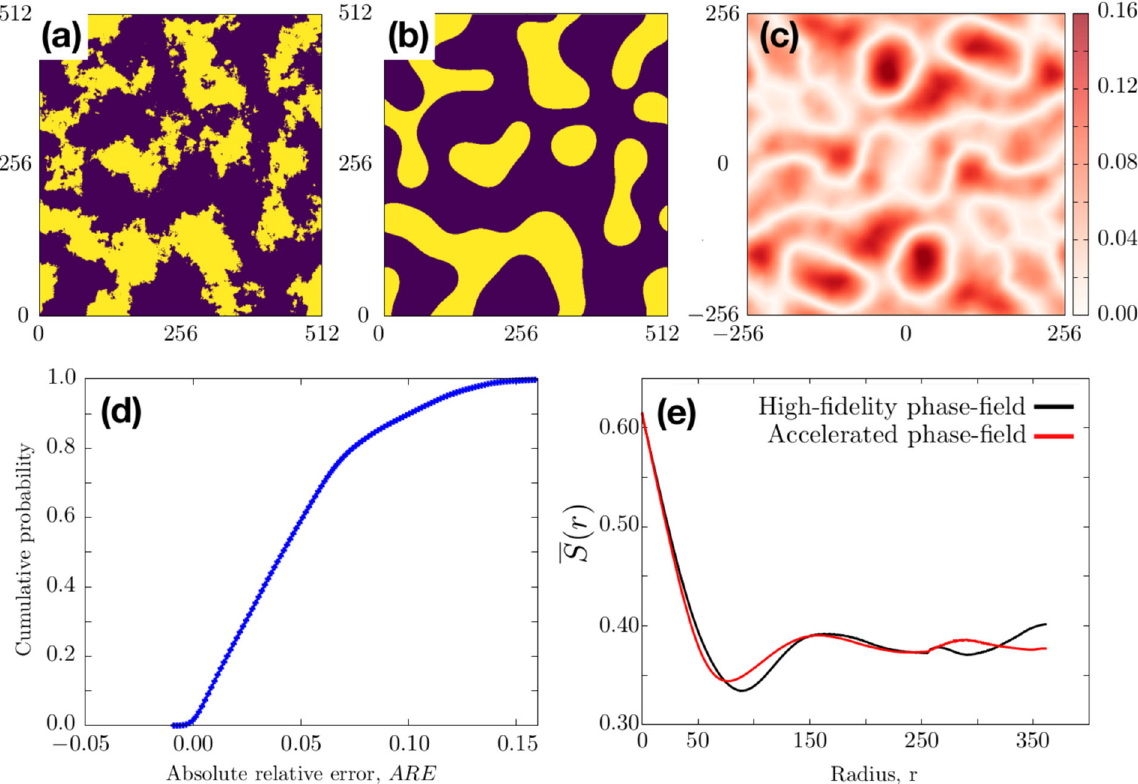
Fig. 5 Accelerated phase- fi eld predictions. a Reconstructed microstructure from the LSTM-trained surrogate model using a phase-recovery algorithm. b Phase- fi eld predictions using LSTM-trained surrogate model as an input. c Point-wise error between predicted and true microstructure evolution. d Cumulative probability distribution of the absolute relative error on characteristic microstructural feature size. e Comparison of radial average of the microstructure autocorrelation between predicted (red) and true (black) microstructure